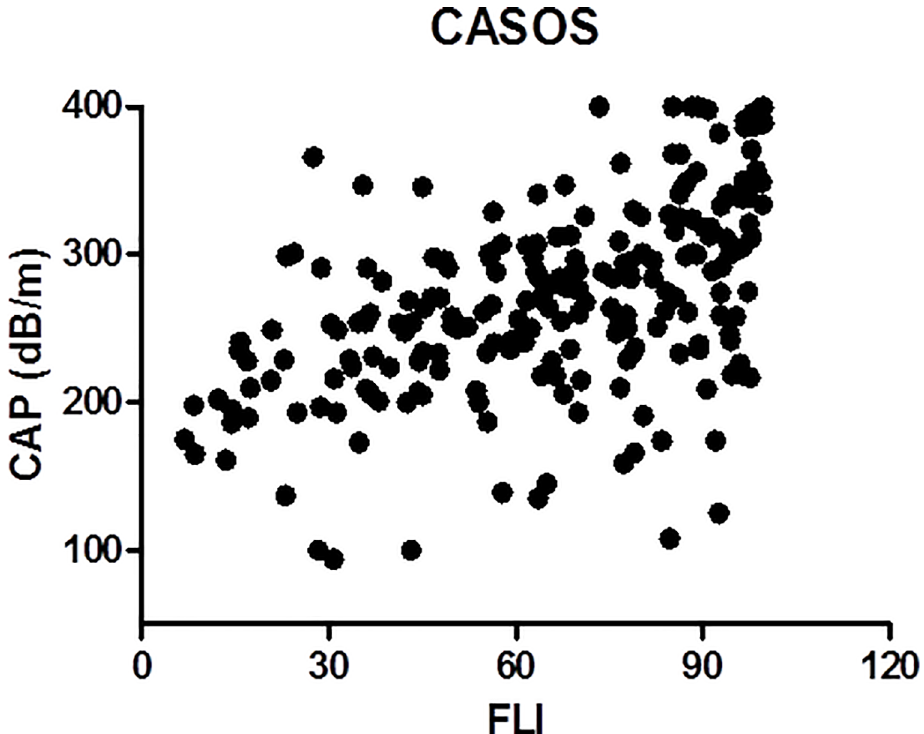
Fig 2. Correlation between CAP and FLI values in the 215 subjects with metabolic risk factors of NAFLD included in the study.